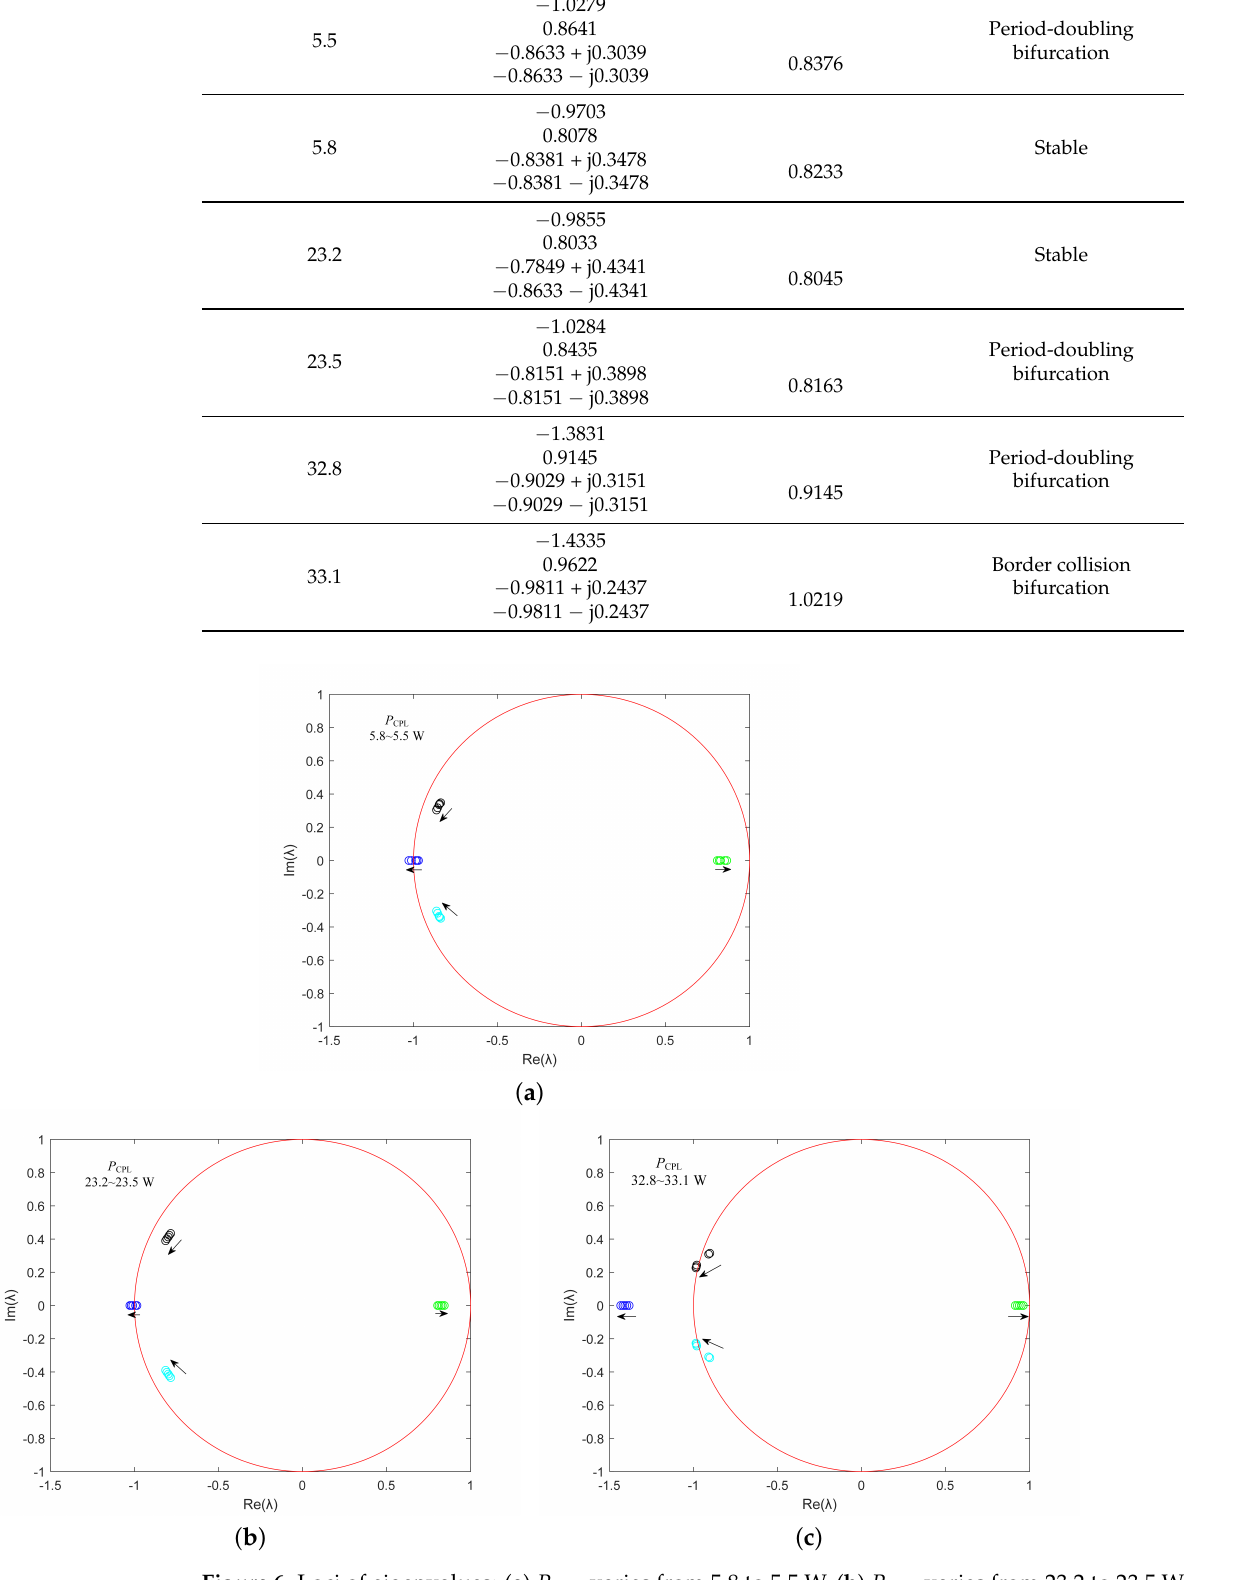
Figure 6. Loci of eigenvalues: ( a ) P CPL varies from 5.8 to 5.5 W. ( b ) P CPL varies from 23.2 to 23.5 W. ( c ) P CPL varies from 32.8 to 33.1